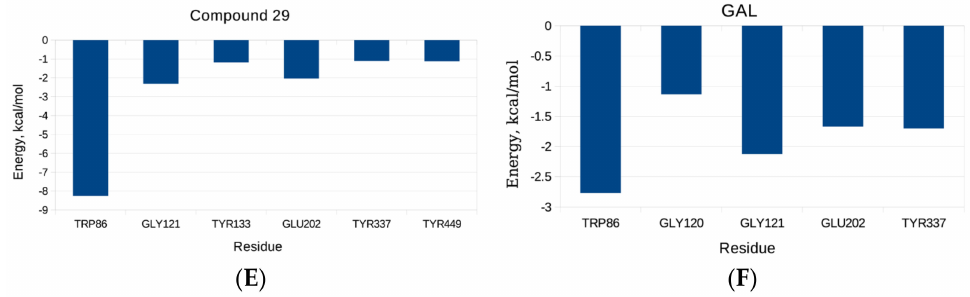
Figure 4. Energy decomposition per residue of predicted compounds ( A ) 22 , ( B ) 28 , ( C ) 21 , ( D ) 9 , ( E ) 29, and ( F ) GAL. The energy contribution larger than 1 kcal/mol is displayed. To gain further insight into the intermolecular interactions between the ligands and the enzyme during the course of the production, dynamics were analyzed using cpptraj V4.14.0 [58]. Compound 22 forms in three hydrogen bonds. Two of them are formed between the O atom from the carbonyl group of the linker and H atoms at N-terminus of Gly121 and Gly122 (Figures 5A and S3A,B). The third hydrogen bond occurs between the O atom from the carbonyl group from the pyridin-2-one moiety of 22 and H atom from the hydroxyl group of Tyr337 (Figures 5A and S3C). The distance between the pyridin-2-one ring of 22 and indole part of Trp86 is appropriate for a π – π contact (Figures 5A and S3D). Distances between atoms during the course of simulation are shown in Figure S3A–D.